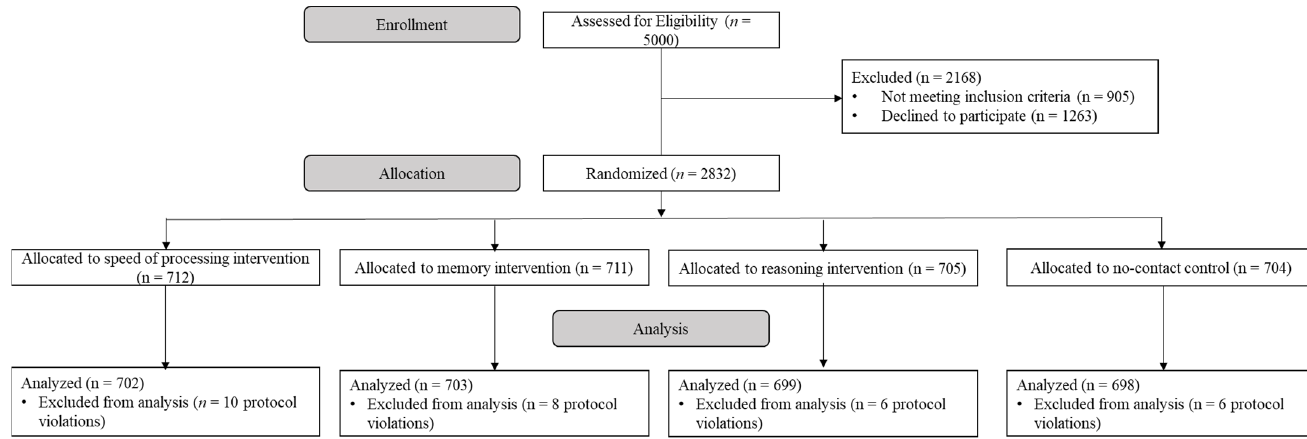
Figure 1. CONSORT flow chart of the ACTIVE trial.